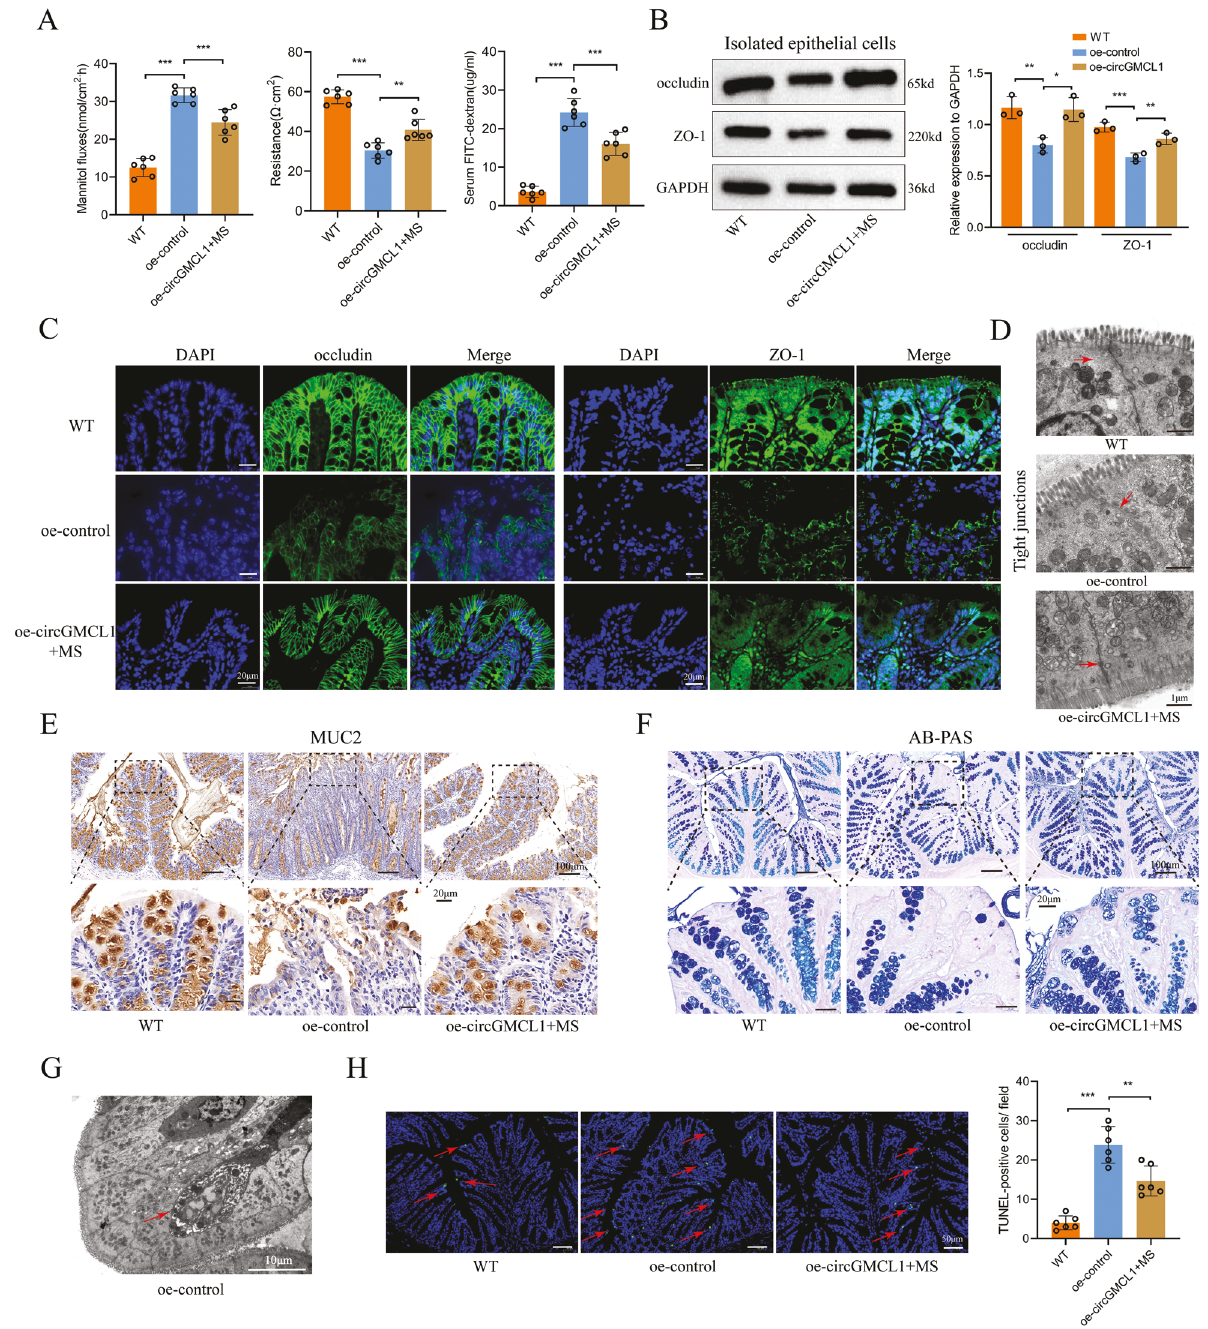
Fig. 7 Impact of circGMCL1 on intestinal barrier function. A Intestinal permeability analyses. B Protein expression of TJ proteins (occluding and ZO-1) as determined by western blotting assay. C Immuno fl uorescence of TJ proteins. D Representative TEM images of TJs. E Immunohistochemical analysis of MUC2. F AB-PAS staining of colon sections. G Representative TEM images of apoptotic body in oe-control IL-10 KO mice. H Apoptosis of intestinal epithelial cells as evaluated using the TUNEL assay. TJ tight junction, TEM transmission electron microscope, FITC fl uorescein isothiocyanate, TUNEL terminal deoxynucleotidyl transferase dUTP nick end labeling, MSs microspheres. Data are presented as mean ± SD. ** P < 0.01, *** P < 0.001 by one-way ANOVA